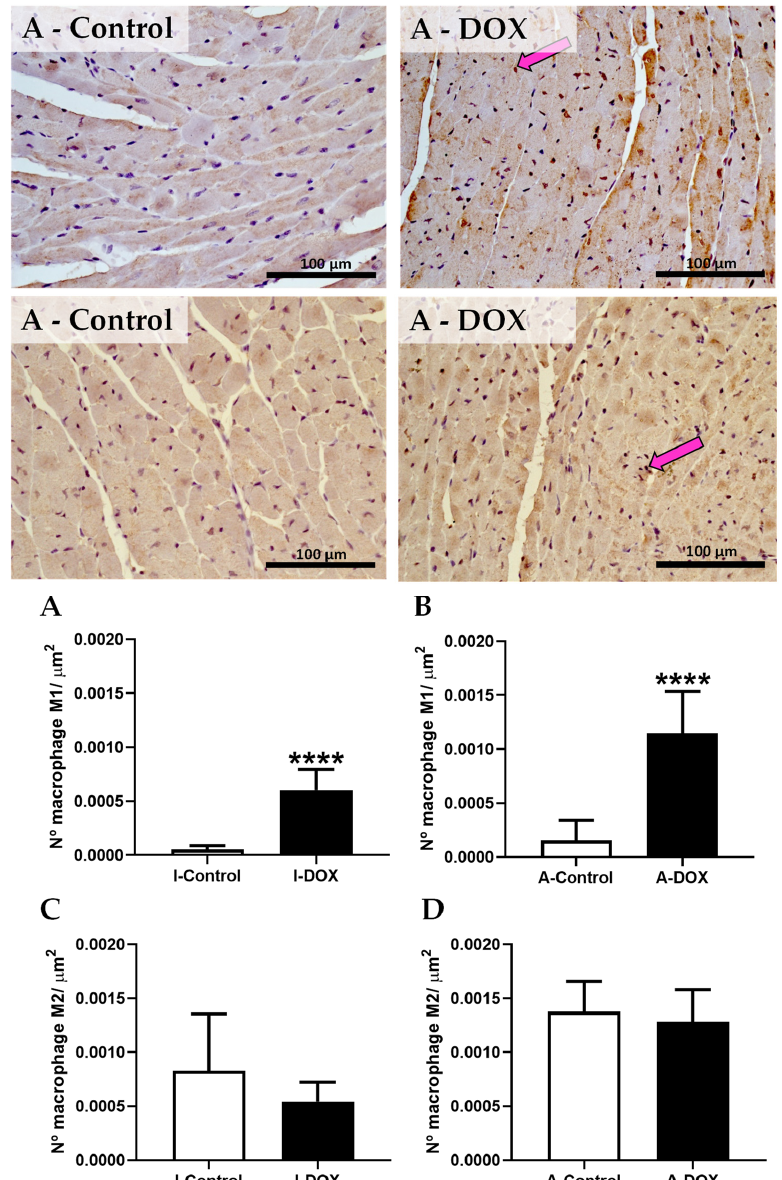
Figure 7. Representative photomicrographs of immunohistochemistry done in cardiac tissue of DOX-treated adult (A-DOX) and respective controls (A-Control), of CD68-positive cells (a marker for the macrophage M1) (on the top line) and of CD206 positive cells (a marker for the macrophage M2) (the bottom histologic figures). Positive stains are indicated by pink arrows. Number of cells staining positive for activated macrophages marked as M1 in adults ( A ) and infants ( B ). Number of cells staining positive for activated macrophages marked as M2 in the heart of ( C ) infant DOX-treated (I-DOX) and control mice (I-Control), and ( D ) adult mice exposed to a cumulative dose of 18.0 mg/kg DOX (A-DOX) and respective controls (A-Control). Results were expressed as the number of positive cells per area ( µ m 2 ) as mean ± SD. Results were obtained from three animals from each treatment group (six random fields per n ). Statistical comparisons were made, using Student’s t -test for macrophage M2 in the infant group and by the Mann–Whitney test for all other analyses: **** p < 0.001, DOX vs. control. Scale bar = 100 µ m, n = 3. Images taken at 40 ×